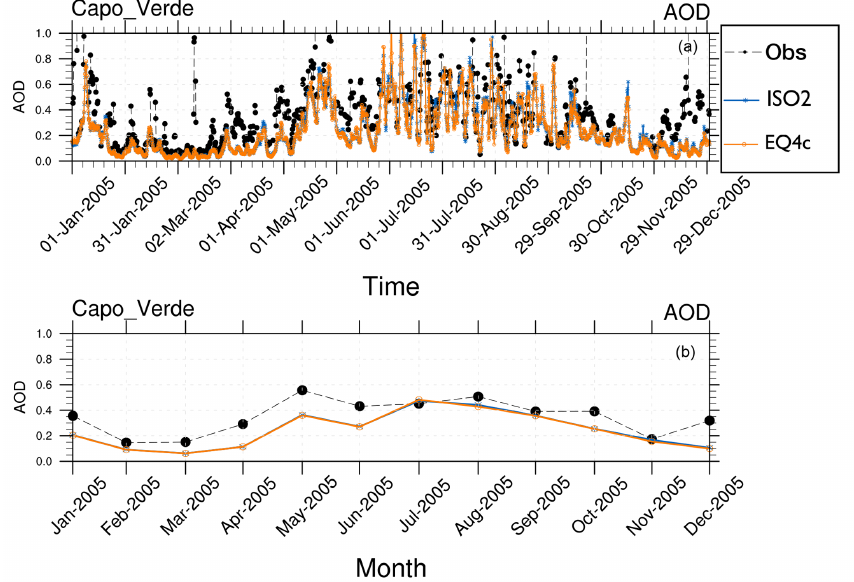
Figure 10. EMAC AOD results versus AERONET observation (Obs) at Cabo Verde (year 2005) with (a) 5-hourly means and (b) monthly means for EQSAM4clim (EQ4c) and ISORROPIA II